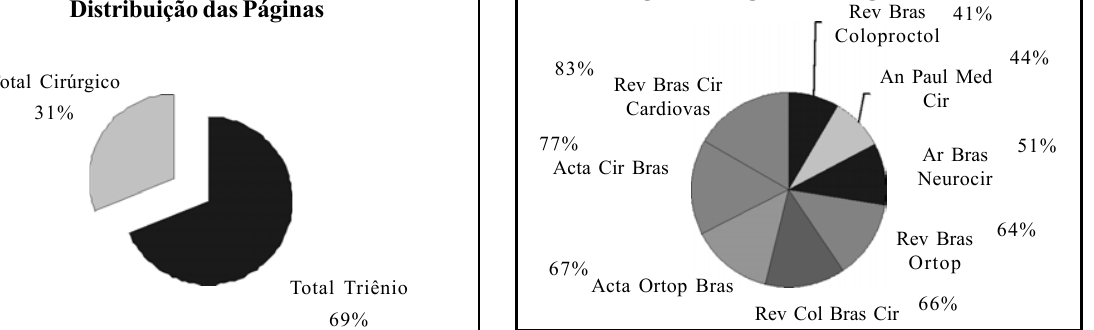
A Tabela 3 apresenta os 23 t(cid:237)tulos selecionados com data inicial do volume 1 e o œltimo volume publicado